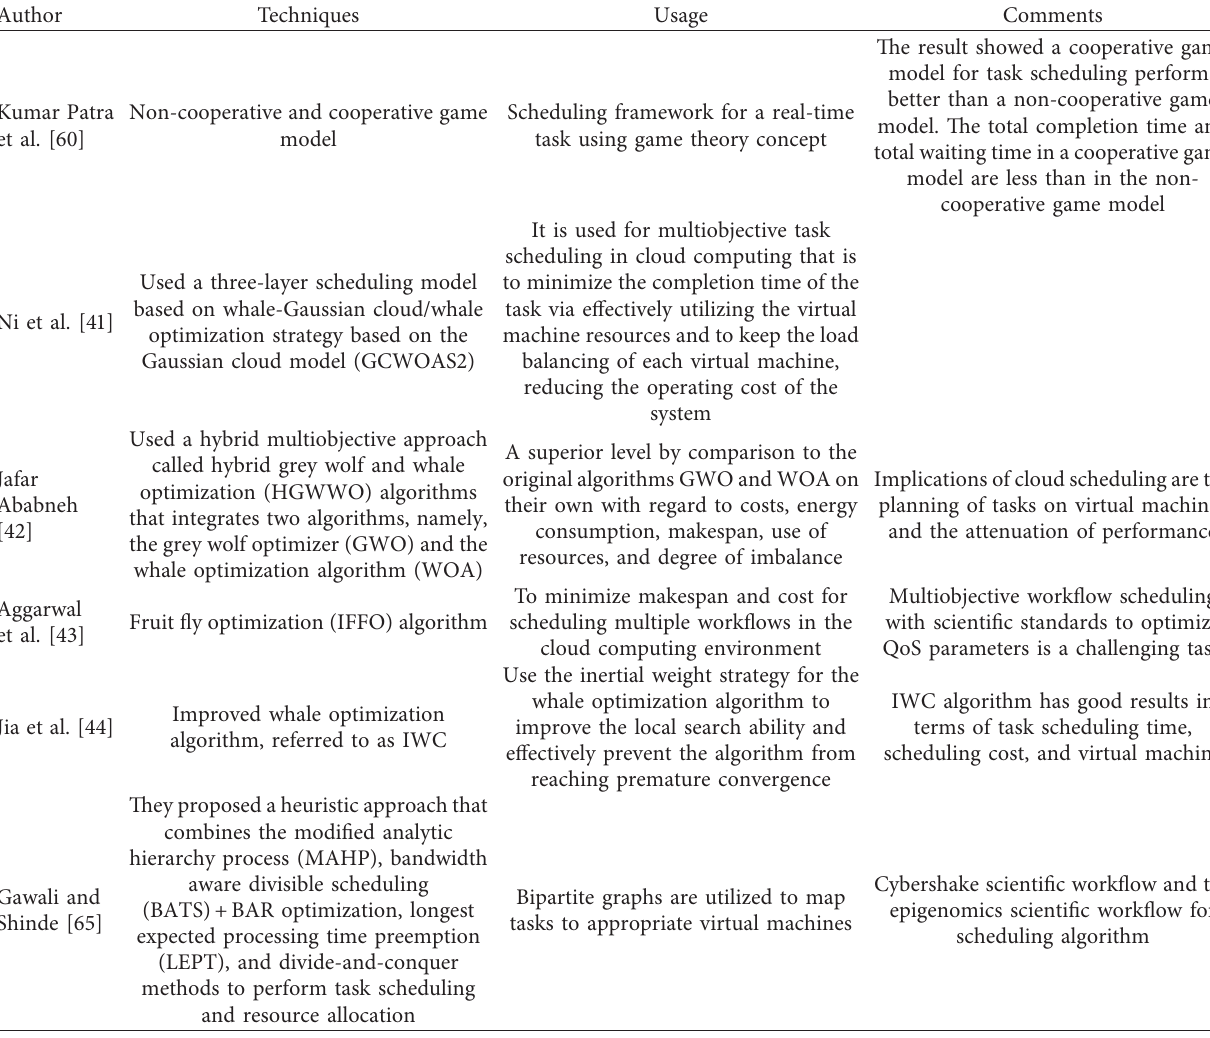
Table 6: A comparative analysis of game-theoretic models for task scheduling in cloud